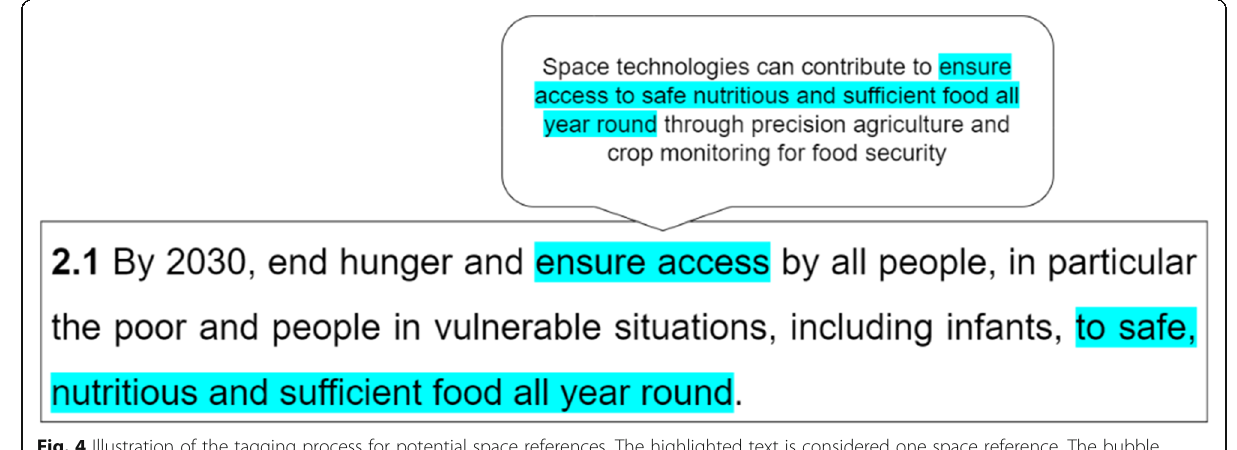
Fig. 4 Illustration of the tagging process for potential space references. The highlighted text is considered one space reference. The bubble indicates the justification for the inclusion of the example as a potential space